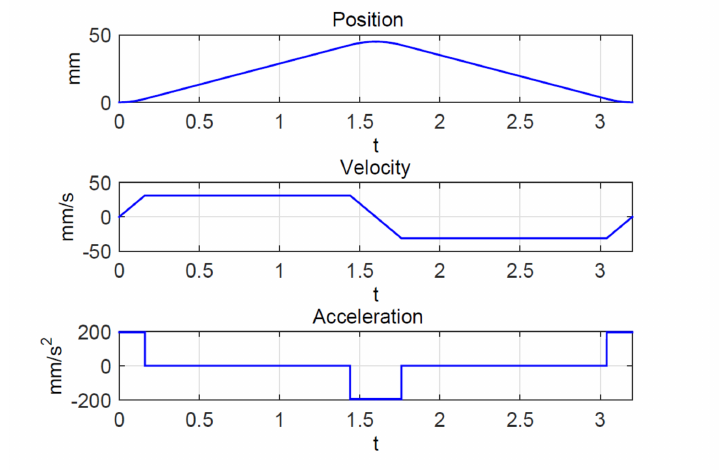
Figure 11. Motion law used for the test.